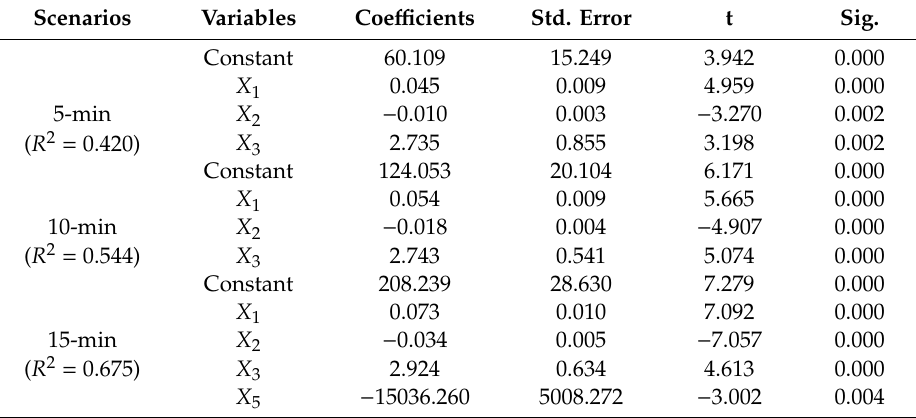
Table 2. Summary of regression model parameters in di ff erent